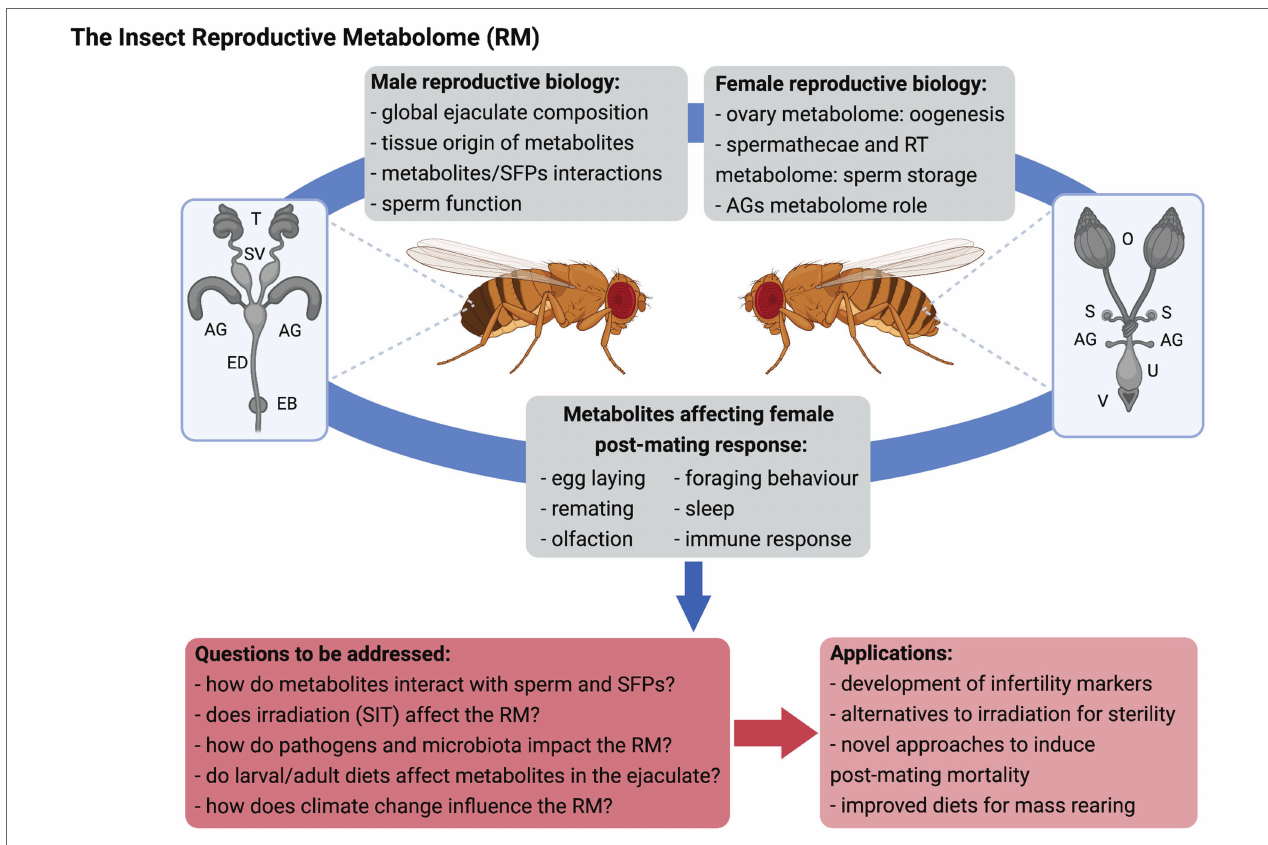
FIGURE 1 | The insect reproductive metabolome (RM). Metabolomics can be applied to the study of male and female reproductive biology and expand knowledge on the physiological mechanisms underlying inter-sexual interactions upon mating, with relevant practical application for insect control. SFPs, seminal fluid proteins; RT, reproductive tract; AG, accessory glands; T, testes; SV, seminal vesicles; ED, ejaculatory duct; EB, ejaculatory bulb; O, ovaries; S, spermathecae; U, uterus; V, vulva; SIT, sterile insect technique; and RM, reproductive metabolome. Figure created with